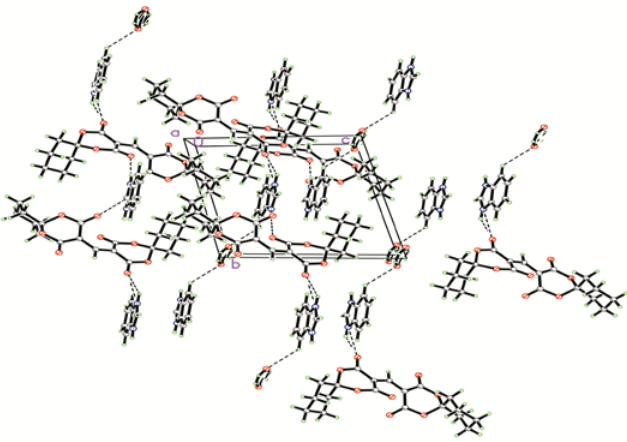
Figure 2. The packing arrangement down the a axis of (C 19 H 21 O 8 ) (C 7 H 7 N 2 ) (0.5H 2 O).